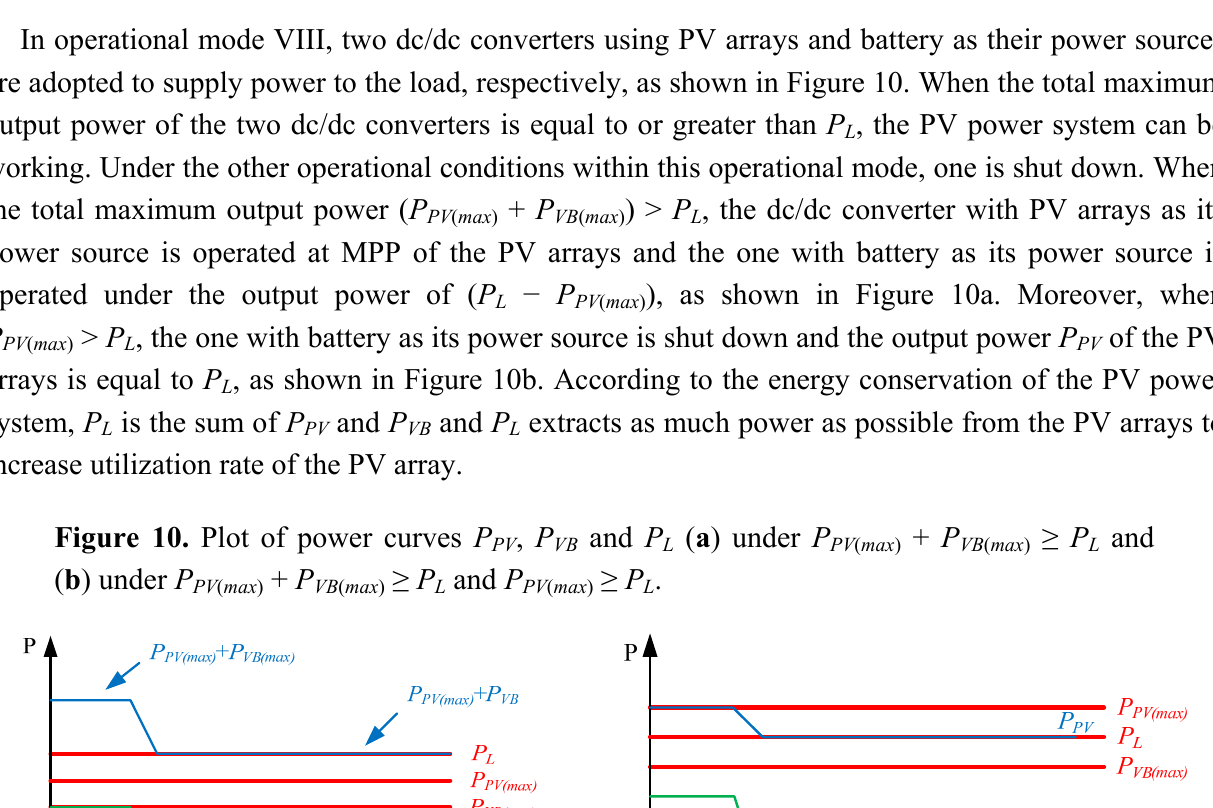
, P and P ( a ) under P PV VB L